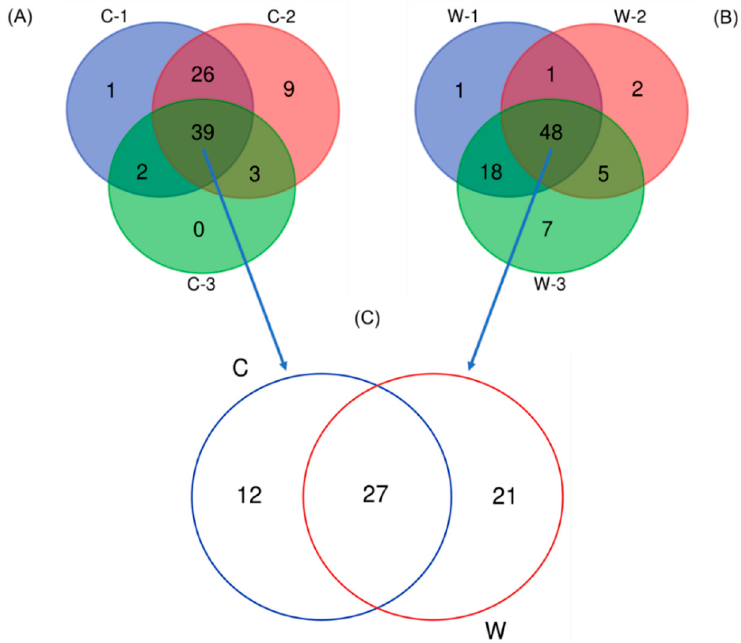
Figure 8. Venn diagrams represent the results of the core microbiota between replicates of each group ( A , B ), and between the control ( C ), and W5 ( W ) groups ( C ). Taken together, the predominant genera (with the highest relative abundances) in shrimp intestines were Vibrio , Spongiimonas , Shewanella , Motilimonas , Demequina , and Pseu- doaltreomonas . However, the relative abundances of the predominant genera varied among the various groups. Vibrio , Spongiimonas , Motilimonas , Paracoccus, and Shewanella were pre- dominant genera in the control; while Vibrio , Sphingomonaas , Pseudoalteromonas , Motilimonas , Shewanella, and Demequina , were predominant in the W5 group (Figure 9).